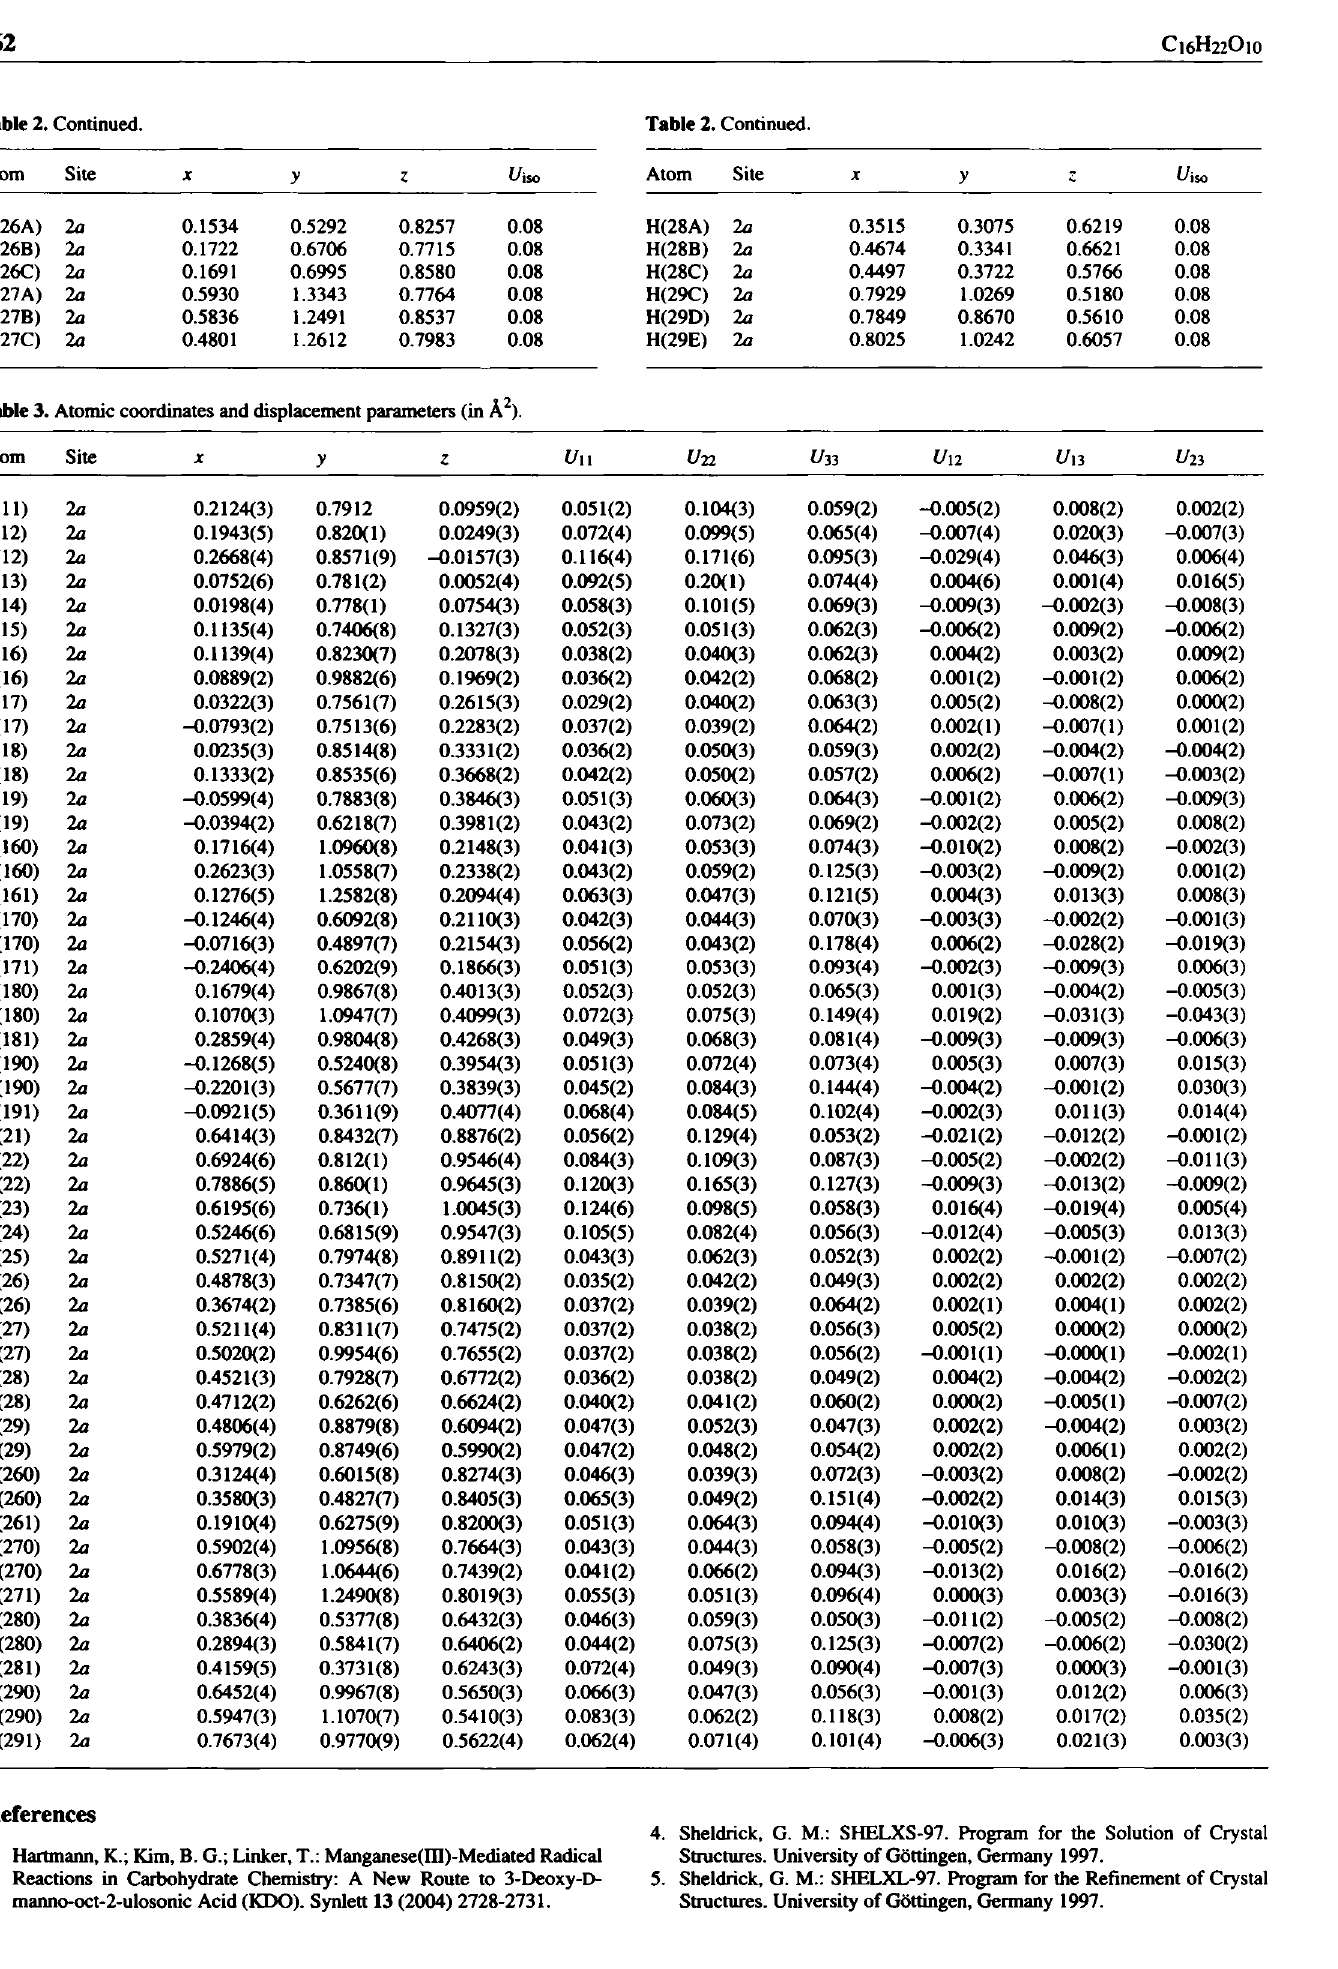
4. Sheldrick, G. M.: SHELXS-97. Program for the Solution of Crystal Structures. University of Gôttingen, Germany 1997. 5. Sheldrick, G. M.: SHELXL-97. Program for the Refinement of Crystal Structures. University of Gôttingen, Germany